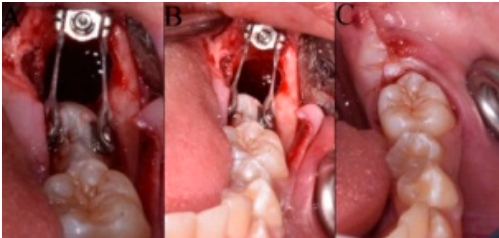
Figure 2. ( A , B ) View of inserted self-drilling miniscrew in the retromolar area, the buccal and oral metal brackets on the crown of mandibular second molar (MM2) and the orthodontic traction with the elastomeric chain; ( C ) Surgical incision closure with sutures.